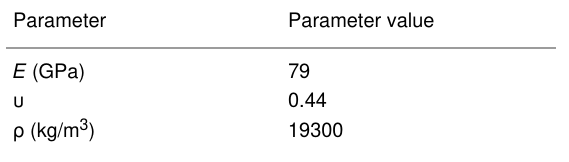
Table 3: Gold nanoparticle design